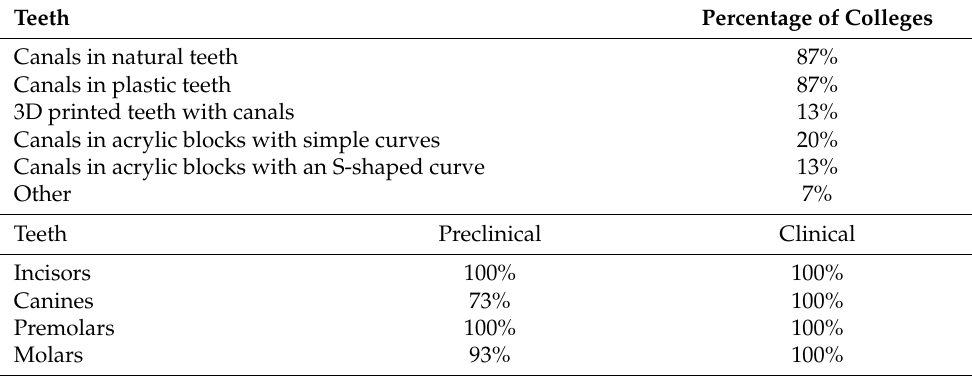
Table 2. Types of root canals and teeth used in preclinical training in Saudi colleges.